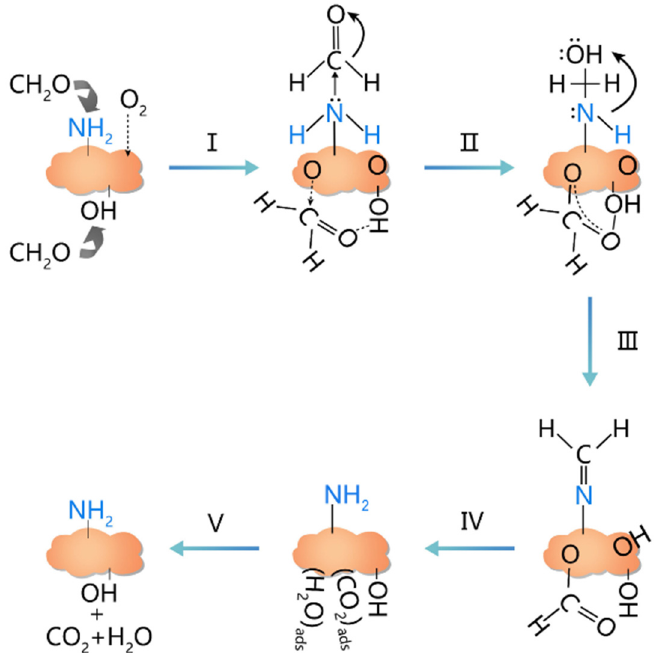
Scheme 1. Schematic diagram of the possible pathway for photocatalytic oxidation of formaldehyde over C 60 ‐ EDA/TiO 2 under simulated sunlight.